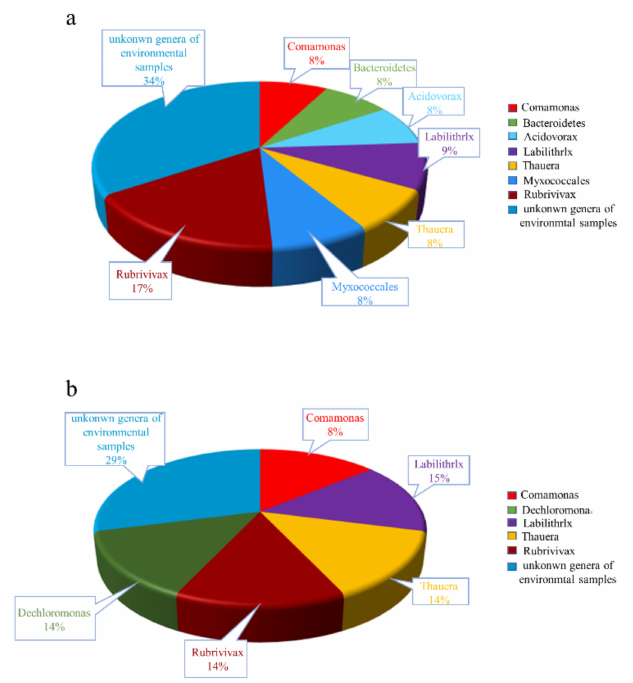
Figure 7. Distribution of microbial community a genus level: ( a ) Reactor 1; and ( b ) Reactor